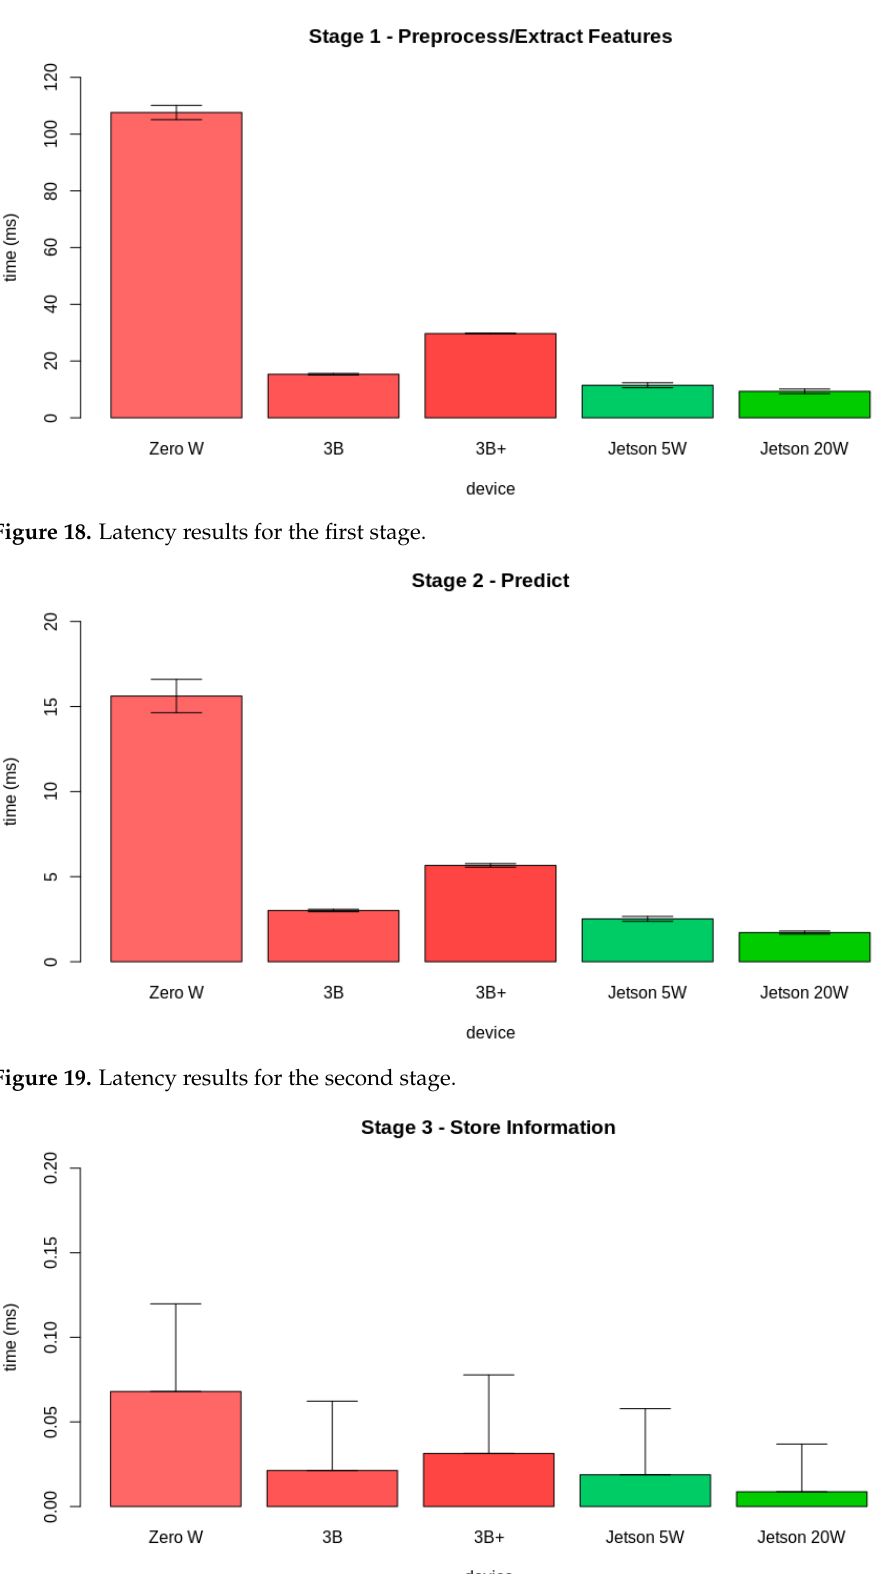
Figure 20. Latency results for the third